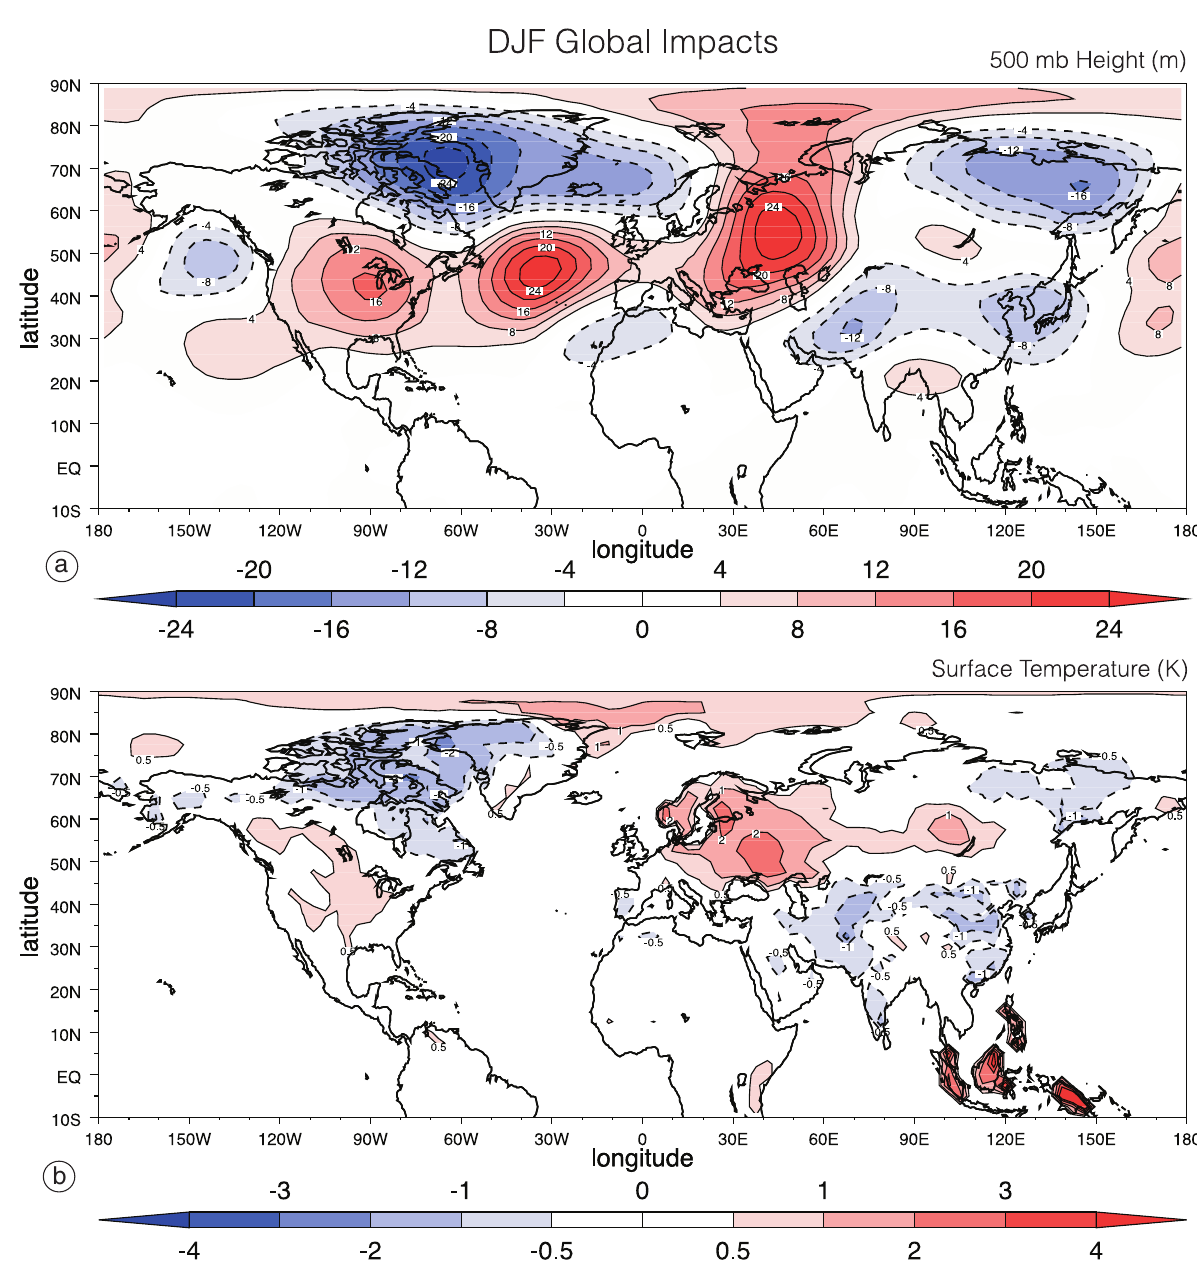
Fig. 2a,b. Seasonal mean differences averaged for 1979-1995 between the sensitivity AMIP II experiment with the Maritime Continent land grid-points removed and the control AMIP II experiment: a) DJF Northern Hemisphere 500-hPa geopotential height (m), and b) DJF Northern Hemisphere surface air temperature (K). From Neale and Slingo